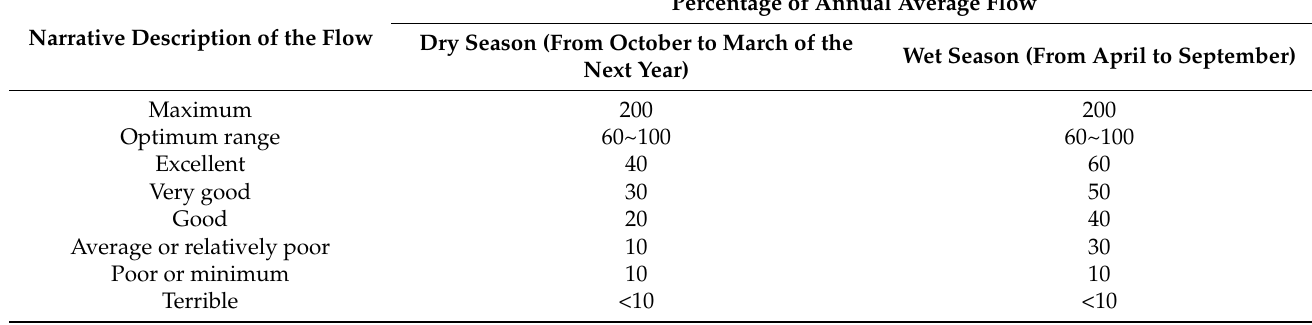
Table 3. River flow conditions for protecting fish, wildlife, entertainment, and related environmental